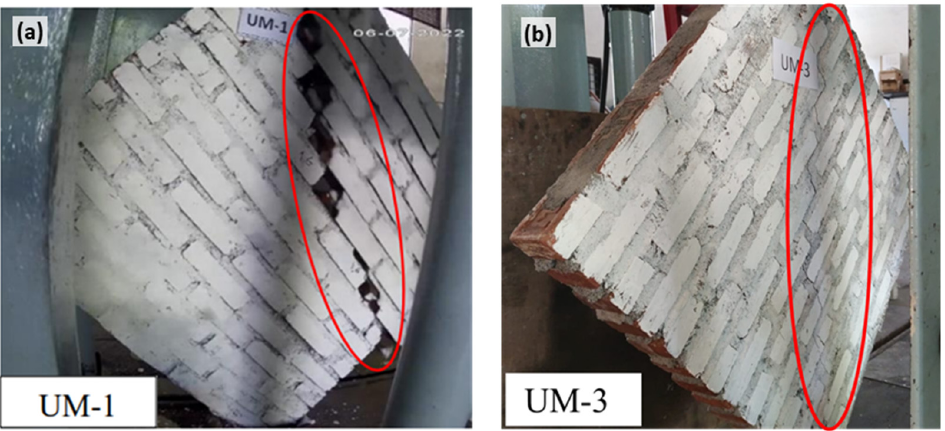
Figure 14. The crack patterns of the two masonry panels, ( a )UM-1, and ( b ) UM-3, under diagonal compressive tests.